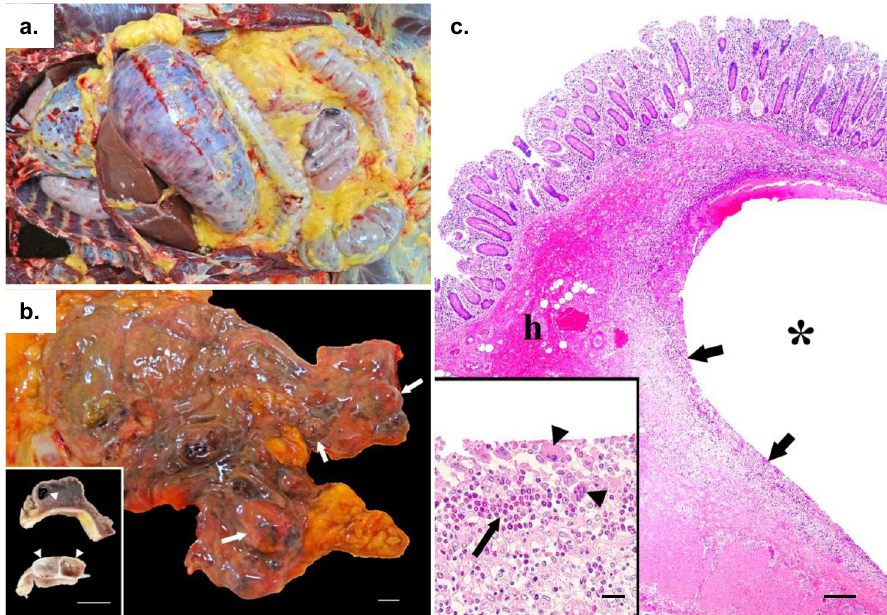
Fig. 3 Gross and histopathologic images of a chimpanzee that died of epizootic neurologic and gastroenteric syndrome (ENGS). Photographic images from an adult male chimpanzee who died of ENGS showing moderate to severe gastric dilation ( a ), hemorrhagic diathesis ( a ), and emphysematous typhlocolitis ( b ; arrows point to gas- fi lled pockets within the cecum wall, which has reddened areas [in inset, white arrowheads point to gas bubbles in the cut surfaces of the formalin- fi xed cecum]; scale bars = 1 cm). On histology ( c ), gas- fi lled space ( * ) in the cecal submucosa, surrounded by in fl ammatory in fi ltrates (arrows) and hemorrhage (h) were visualized by hematoxylin and eosin staining (inset depicts in fl ammatory in fi ltrates, which include eosinophils [arrow] and multinucleate giant cells [arrowheads]; scale bars = 300 µ m [main image] and 30 µ m [inset]; micrograph is a representative image of three similar sections obtained from the same